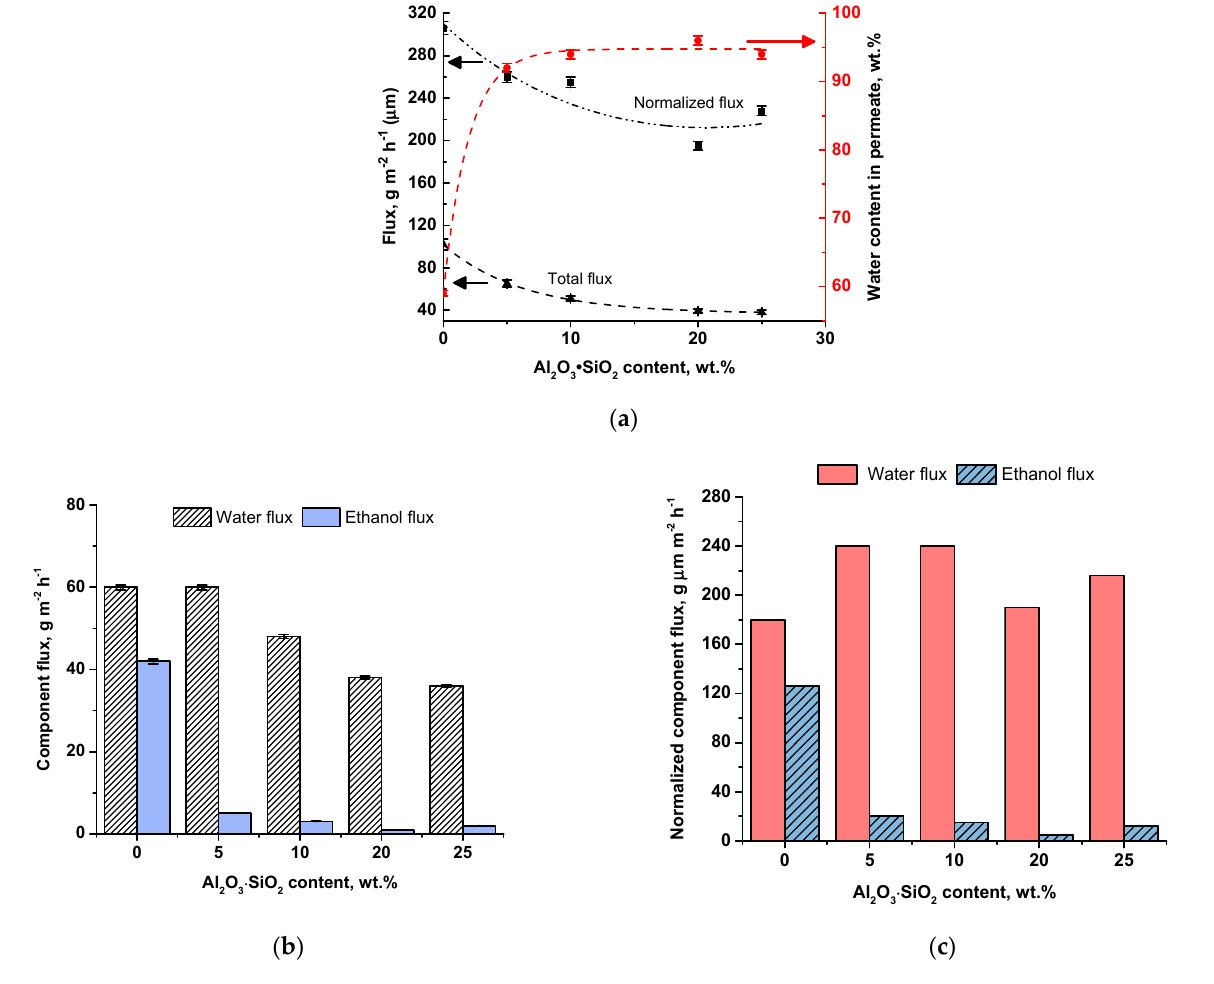
Figure 4. The dependence of TFC and TFN membrane total flux, thickness normalized flux and water content in permeate ( a ), component fluxes ( b ) and normalized component fluxes ( c ) on the content of Al 2 O 3 ·SiO 2 nanoparticles.